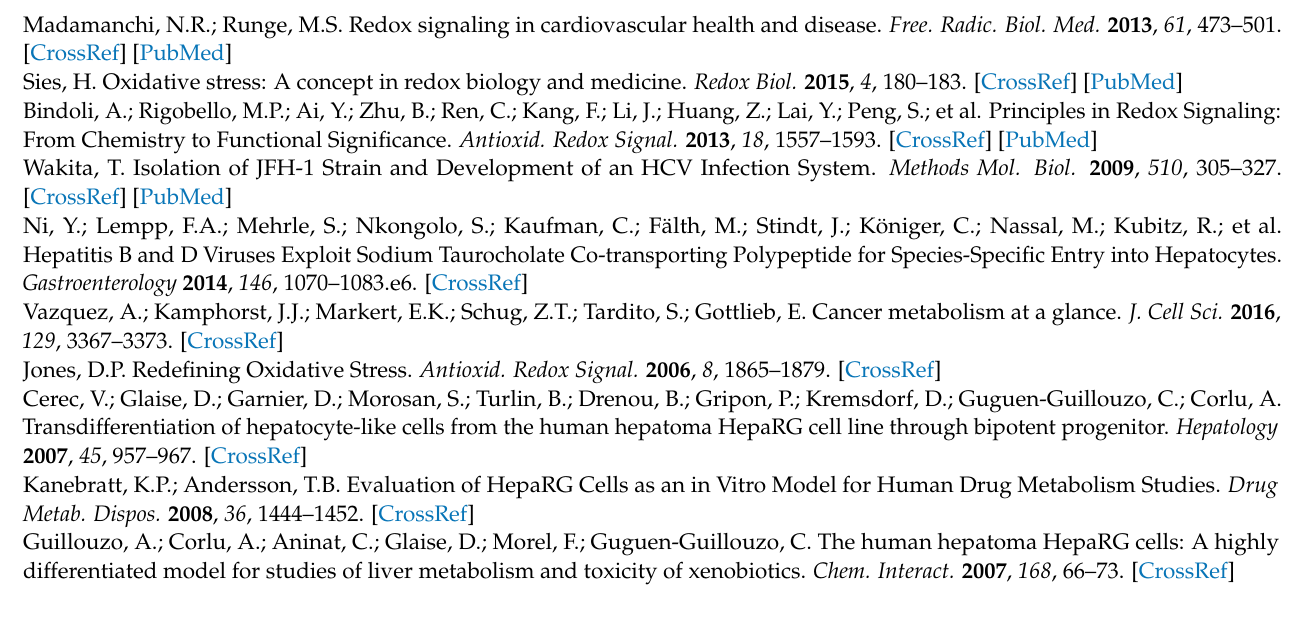
PCR; Figure S1: Expression of NAD(P)H:quinone oxidoreductase (Nqo1), proline dehydrogenase (PRODH) and argininosuccinate synthase (ASS1) in hepatoma Huh7.5 cells, hepatocyte-like HepaRG cells and in HepaRG cells treated with DENSpm, assessed by western blot